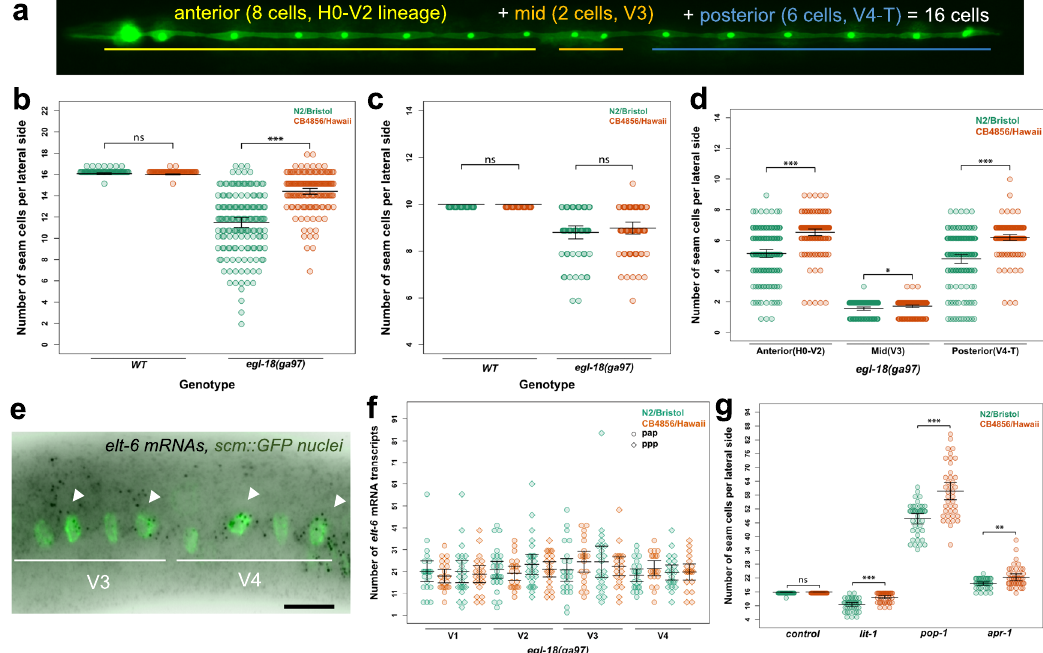
Fig. 1 The egl-18(ga97 ) mutation results in lower seam cell number in the N2 background compared with CB4856. a Image depicting the stereotypic seam cell distribution in wild-type animals at the end of larval development, where eight cells are positioned anterior to the vulva (H0 – V2), two cells are near the vulva (V3 lineage) and six cells are found posterior to it (V4 – T). b Average terminal seam cell number (SCN) is signi fi cantly lower in N2 (green) than CB4856 (orange) carrying the egl-18(ga97) mutation (one-way ANOVA F (1, 310) = 115.02, p < 2.2 × 10 − 16 , n ≥ 150), but is not different in wild-type isolates (one-way ANOVA F (1, 142) = 0.13, p = 0.13, n = 72 independent animals for wild-type and n = 150 or 162 independent egl-18 mutants in N2 and CB4856 respectively). c No statistically signi fi cant difference in SCN is found between N2 and CB4856 wild-type isolates or egl-18(ga97) mutants at the end of L1 stage with one-way ANOVA ( p > 0.32, n = 60 and 64 independent egl-18 mutant animals in N2 and CB4856 and n = 25 independent animals for wild-type). d Seam cell number comparison between egl-18(ga97) mutants in N2 and CB4856 when seam cells are classi fi ed based on their position (anterior, mid, posterior). Differences in SCN are signi fi cant between the two isolates for all classes based on one-way ANOVA ( F (1, 310) = 66.41, 4.87 and 61.78, * p < 0.03 and *** p < 0.0001, n ≥ 150 independent animals). e Representative smFISH image showing elt-6 expression in posterior seam cells in an egl-18 mutant at the late L2 stage. Seam cell nuclei are labelled in green due to scm::GFP expression and black spots correspond to elt-6 mRNAs. A similar pattern of expression was observed in three independent experiments. Scale bar is 20 µ m. f Quanti fi cation of elt-6 expression by smFISH in N2 ( n = 186 cells) and CB4856 ( n = 164 cells) carrying the egl-18(ga97) mutation. No statistically signi fi cant difference in the mRNA was found with one-way ANOVA ( F (1, 348) = 0.13, p = 0.72). g SCN quanti fi cation in N2 and CB4856 strains upon knockdown of lit-1 , pop-1 , and apr-1 . There is a signi fi cant